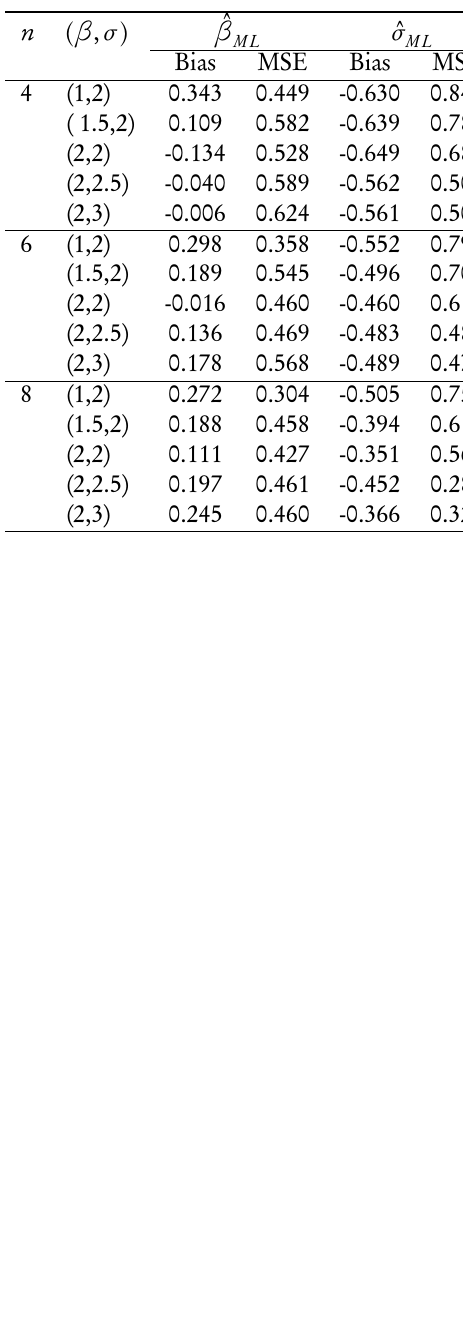
The bias and MSE of MLEs of β and σ for k = 3